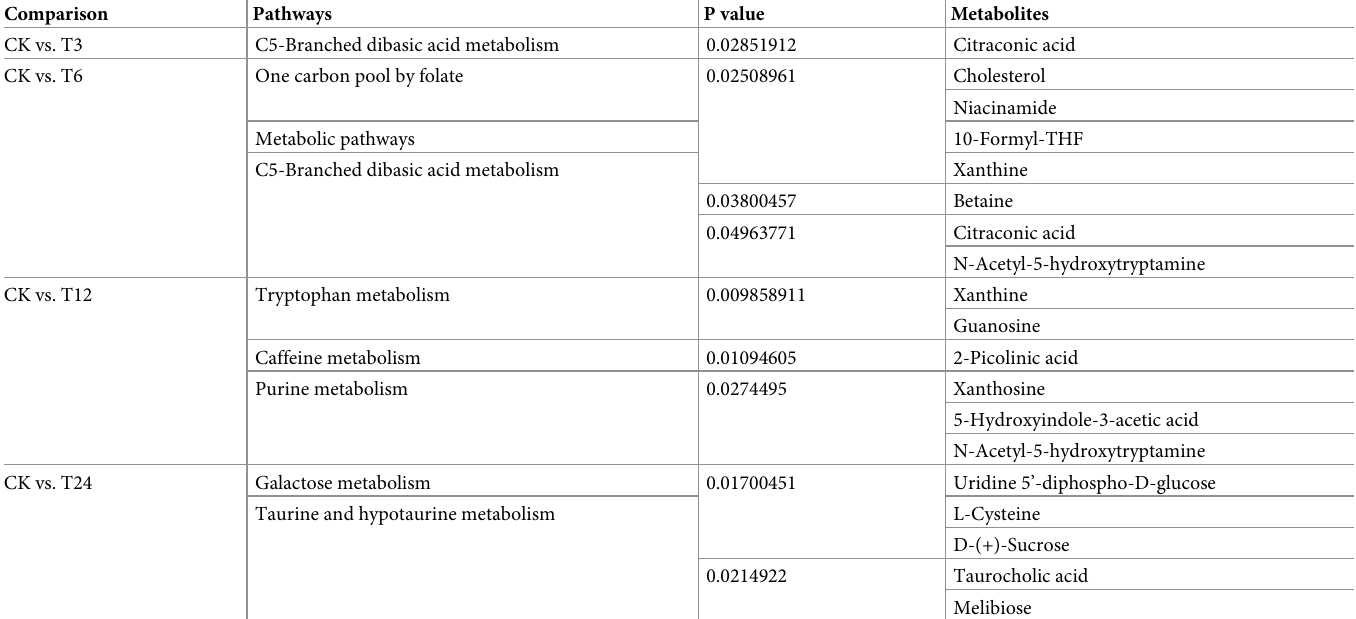
Table 1. KEGG enrichment analysis results on all